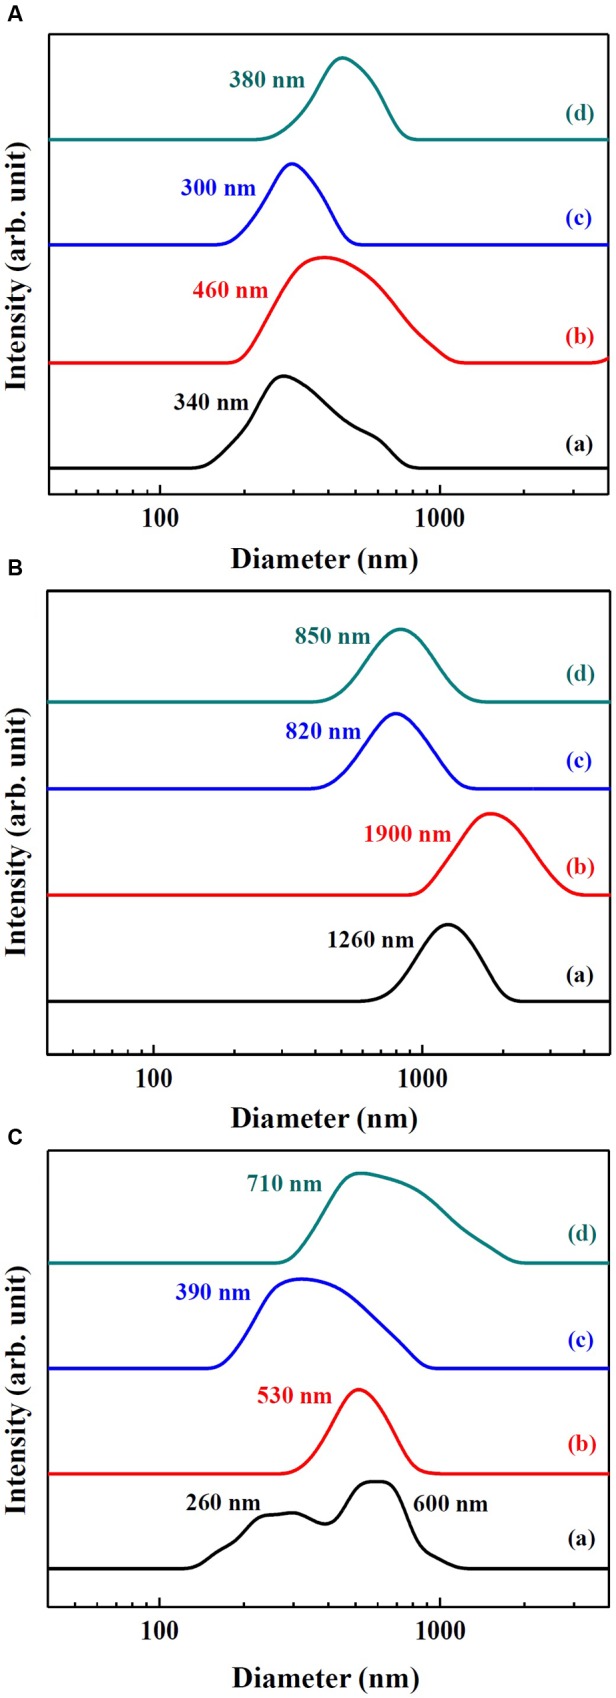
Hydrodynamic radius of (a) SunActive FeTM, (b) FePP, (c) SunActive ZnTM, and (d) ZnO-NPs in
(A) MEM, (B) simulated gastric solution, and (C) simulated intestinal solution.